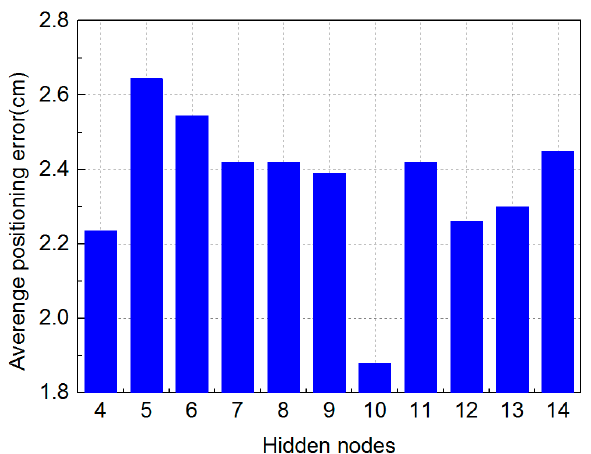
Figure 12. Positioning error with different numbers of hidden layer nodes under the arbitrary training